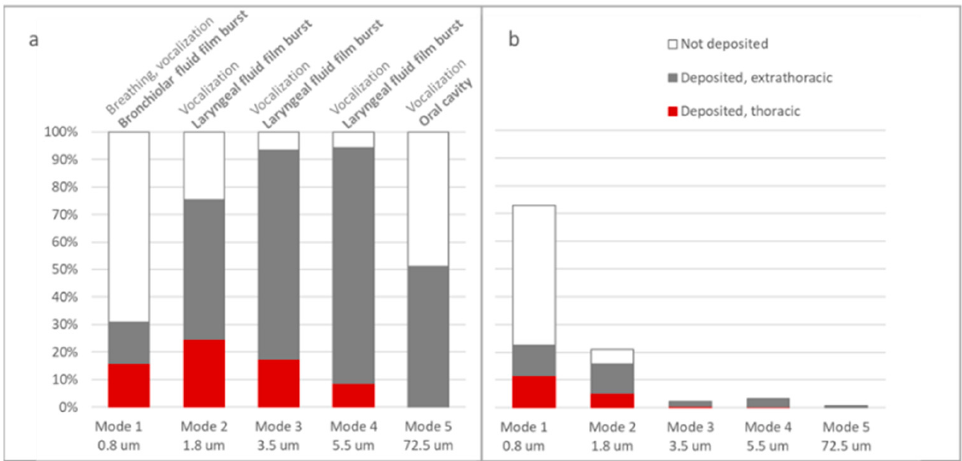
Figure 4. Respiratory tract deposition of the inhalable fraction of ARAPs; originating from exhalation activity “voiced counting”, a combined process of vocalization and breathing. These maneuvers resulted in an ARAP size distribution represented by five modes (0.8, 1.8, 3.5, 5.5, 72.5 µm) that originated from bronchiolar and laryngeal fluid film burst and the oral cavity. Depending on size, different fractions of ARAPs are deposited in the thoracic or extrathoracic region of the respiratory tract, or are not retained and exhaled. Deposition data are shown ( a ) unweighted and ( b ) weighted by relative abundance in the exhalation plume (mode 1–5: 72.8%, 21.0%, 2.2%, 3.4%, 0.6% [12,14]).